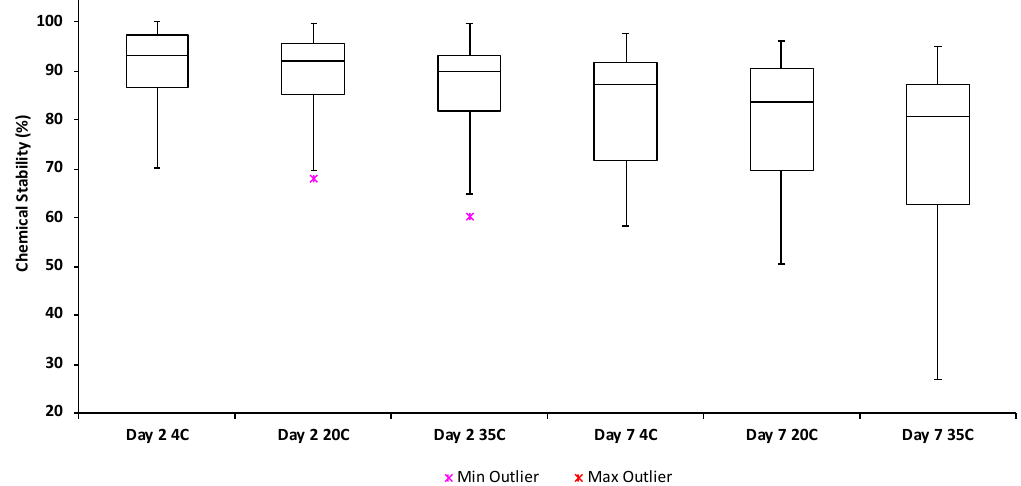
Figure 2. Stability of the target chemicals in liquid chromatography-mass spectrometry (LCMS)-grade water held at 4 °C, 20 °C and 35 °C for 2 and 7 days respectively.